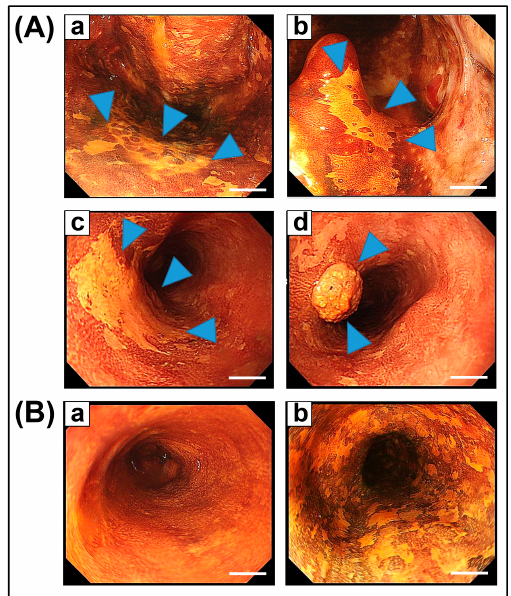
Figure 2. Lugol chromoendoscopic images. ( A ): “Field cancerization” in a patient with esophageal squamous cell carcinoma (ESCC) and head and neck squamous cell carcinoma (HNSCC) synchronously. Location of ( a ) oropharynx, ( b ) uvula, ( c ) upper thoracic esophagus, and ( d ) lower thoracic esophagus. Lesions are indicated by arrowheads. ( B ): ( a ) normal esophageal mucosa, ( b ) esophageal mucosa with multiple dysplastic lesions known as multiple Lugol-voiding lesions. Scale bar = 0.5 cm.